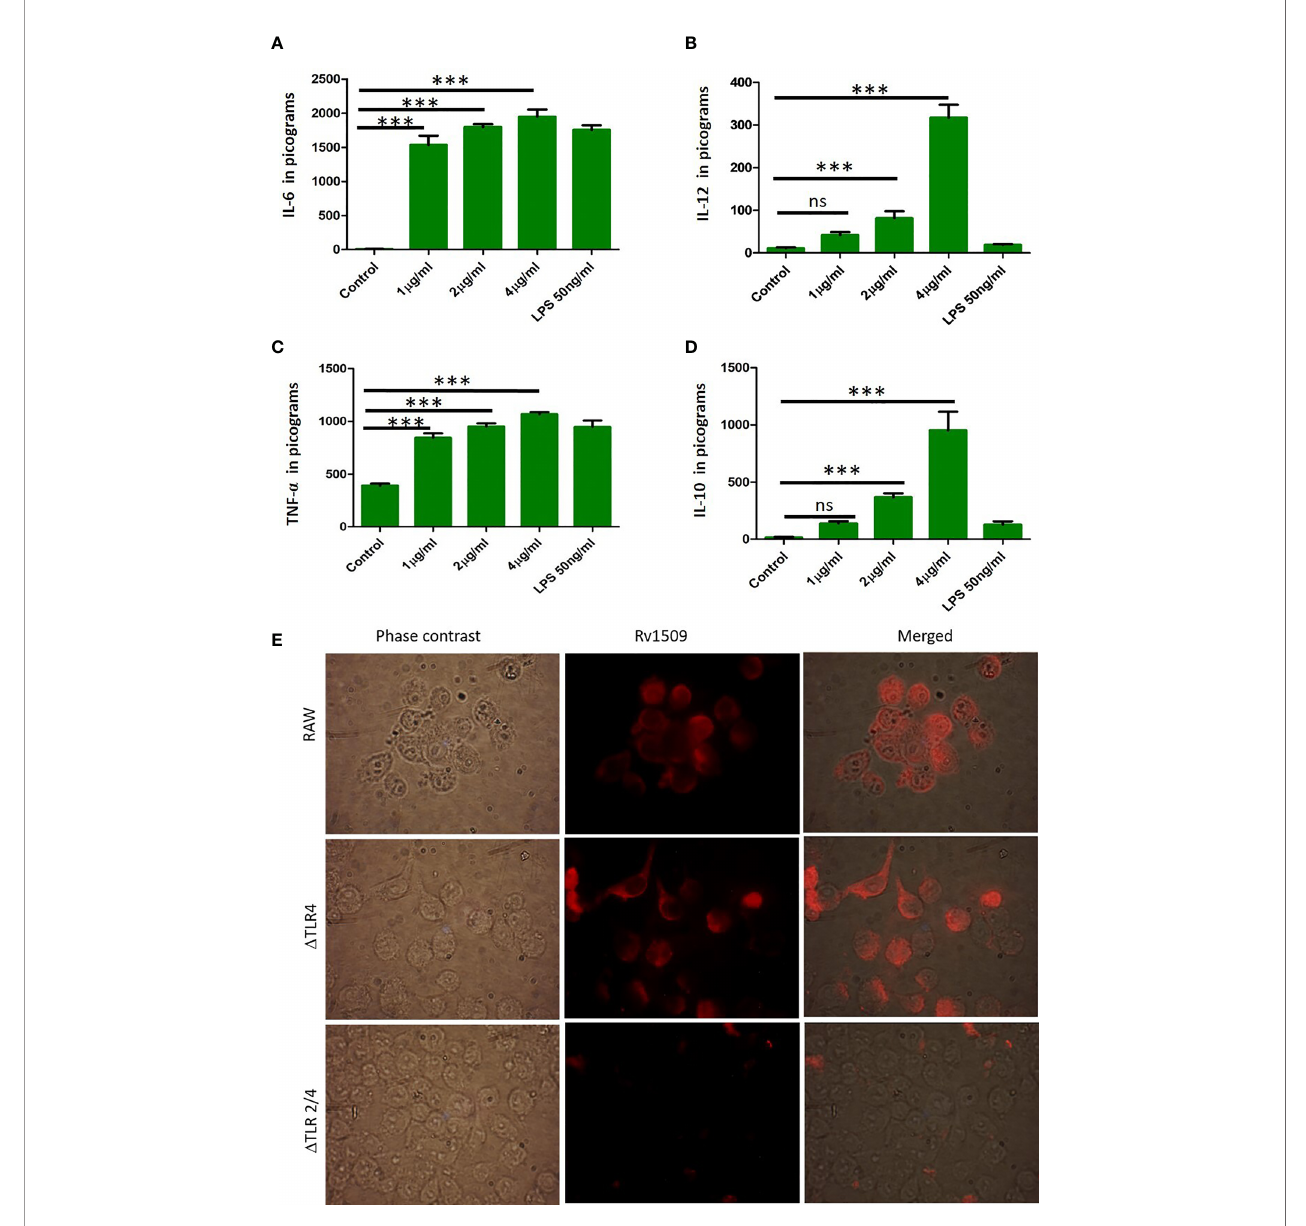
FIGURE 4 | Cytokine secretion by RAW264.7 cells upon treatment with Rv1509 protein. (A – C) RAW 264.7 cells were seeded (0.3×10 6 cells/well) in a 24 well plate. After 12 hours of incubation cells were treated with Rv1509 protein in a dose dependent manner(1 m g, 2 m g and 4 m g/ml) along with positive control (LPS) and negative control (no protein). The supernatants were collected 48 hrs post treatment and cytokines were estimated. The quanti fi ed data are presented as bar graphs. IL-6, IL-12 and TNF a (pro in fl ammatory cytokines) depicted increase in production against Rv1509 protein in a dose dependent manner compared to the control (no protein) and LPS (positive control). (D) The bar graph represents the secretion of anti-in fl ammatory cytokine IL-10 by RAW 264.7 cells upon treatment with Rv1509 protein. Representative data is from three individual experiments with minimum triplicates in each. (The data are expressed as mean ± SD). ***p < 0.001. (E) Immuno fl uorescent images of D TLR4, D TLR2/4 and RAW264.7 cells treated with Rv1509 protein (10µg/ml) and its localization in these macrophages. The cells were fi xed after 6hrs of protein treatment followed by staining with anti Rv1509 antibody (prepared in-house). AlexaFluor 594 (Anti rabbit IgG) used as a detection antibody. Images were acquired using Fluorescent microscope (Olympus) at 100X (Oil immersion) magni fi cation. ns, non-signi fi